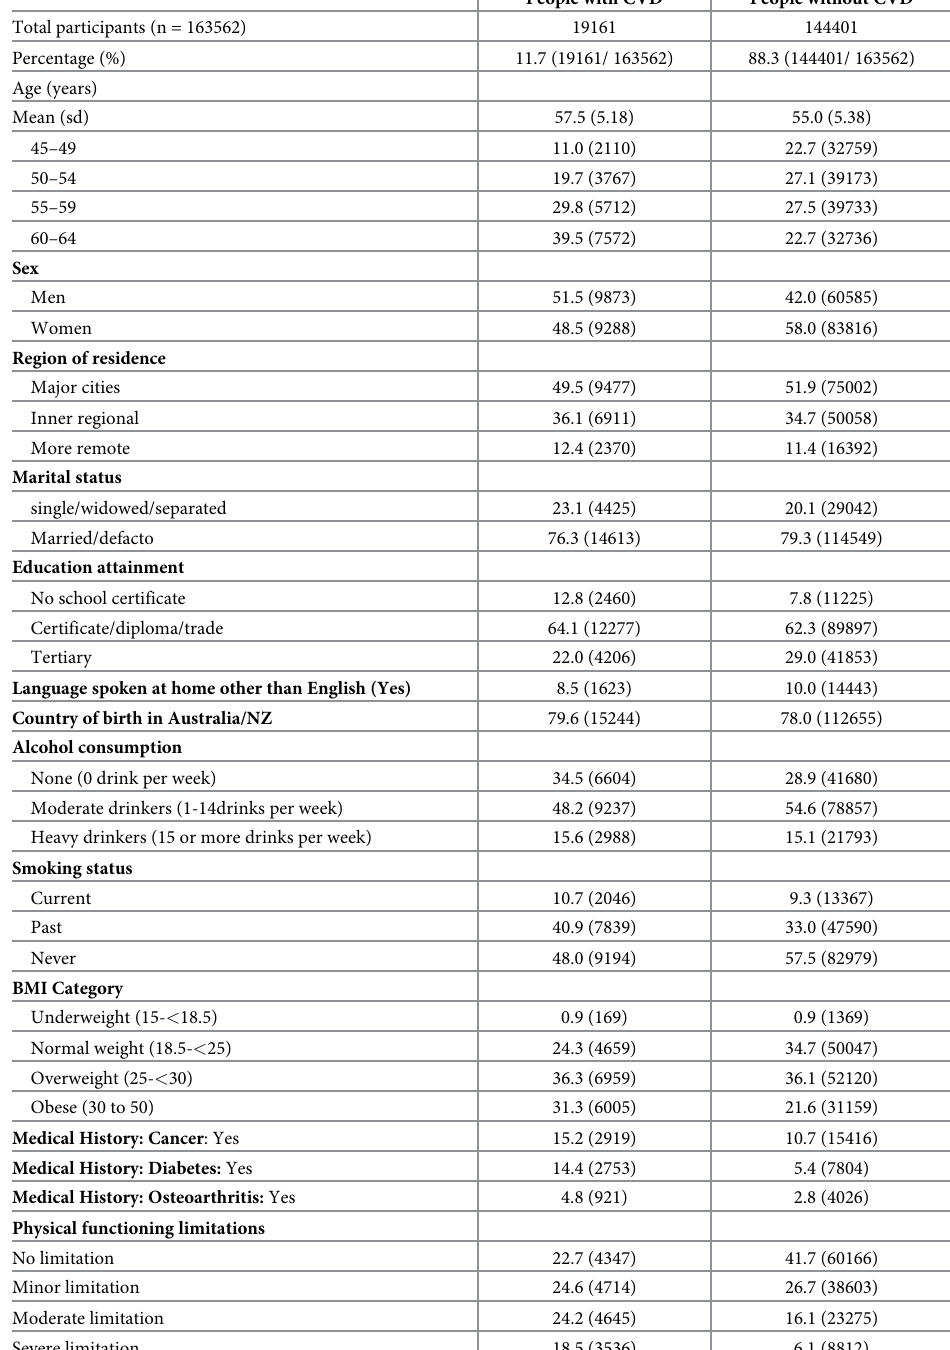
Table 1. Sociodemographic and health related characteristics of study